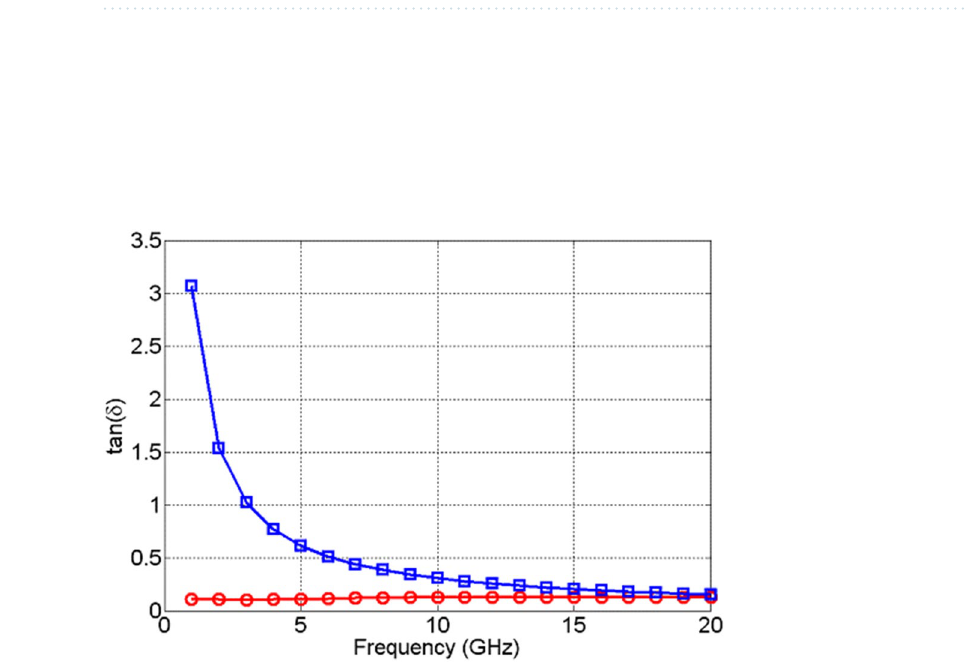
Figure 17. Extracted loss tangents of NiO (red circles) and TiO 2 in OFF state (blue squares).